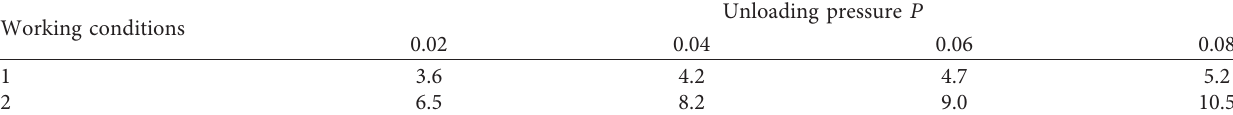
Figure 14: Settlement curve groove and failure pattern of surrounding rock in working condition 2. Table 4: Maximum settlement value at the same unloading level